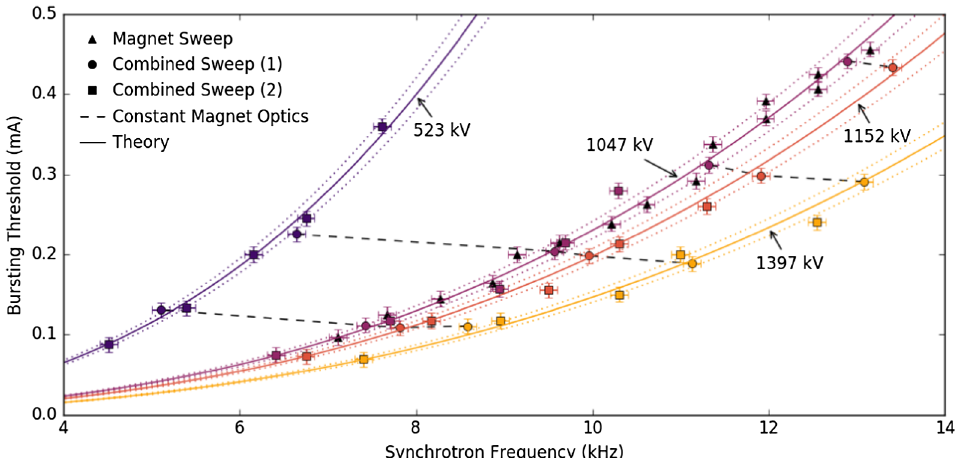
FIG. 6. Measured bursting thresholds from three sets of measurements as a function of the synchrotron frequency. Here “ combined sweep (2) ” refers to the same measurements taken at 11 months apart from “ combined sweep (1). ” For “ combined sweep (1), ” measurement with the same magnet optics are connected by dashed lines. The different colors indicate the different acceleration voltages. The horizontal error bars indicate the systematic error on the measured synchrotron frequency. The vertical error bars include the error of the algorithm for the automated threshold detection, the bunch current measurement as well as the expected spread of the threshold due to multibunch effects. The solid lines show the theoretical expectation according to Eq. (2) from the bunched-beam theory. The dotted lines indicate the one standard deviation uncertainties on the theoretical predictions. Within uncertainties all measurements agree with the bunched-beam